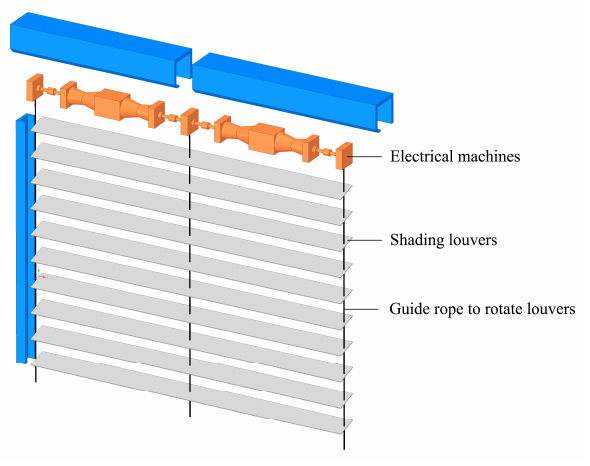
Figure 1. Control system of shading louvers.